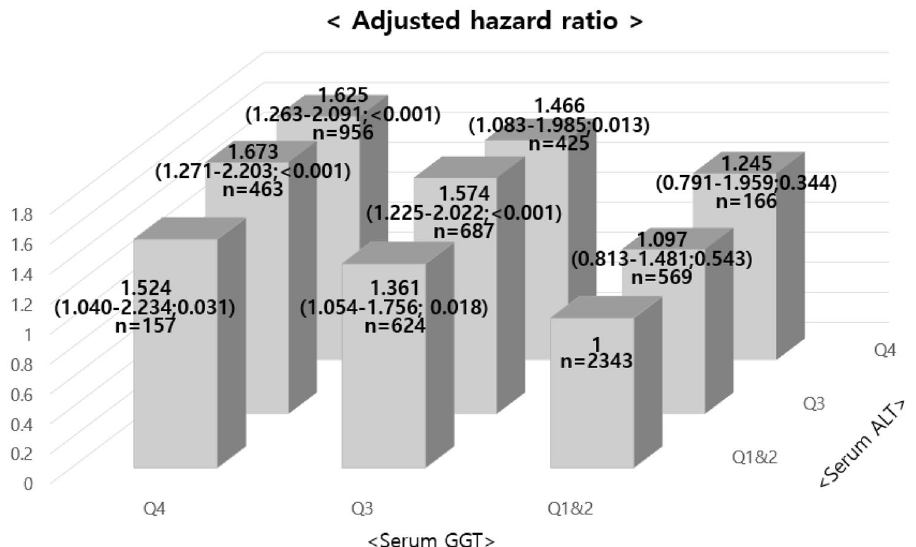
Figure 2. Adjusted hazard ratios * (95% confidence interval; P) for the development of impaired fasting glucose according to the categories of combined ALT and GGT levels (1st and 2nd quartile, 3rd quartile, and 4th quartile) in longitudinal analysis. * The model was adjusted for age, gender, body mass index, log-transformed weekly alcohol consumption, current smoker, hypertension, hyperlipidemia, and uric acid. Q1 1st quartile, Q2 2nd quartile, Q3 3rd quartile, Q4 4th quartile, ALT alanine aminotransferase, GGT